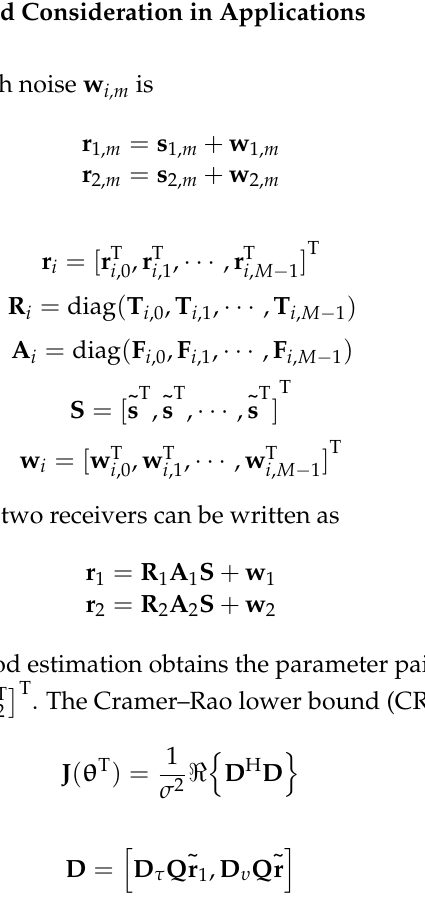
Figure 4. Refining TDOA and FDOA estimations.